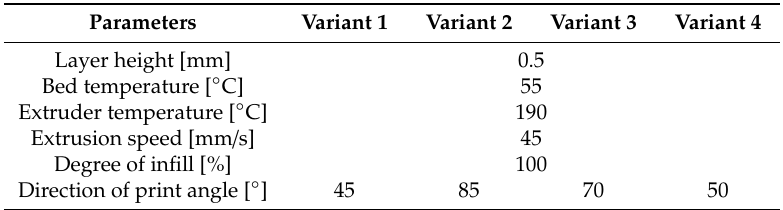
Table 1. Parameters of 3D